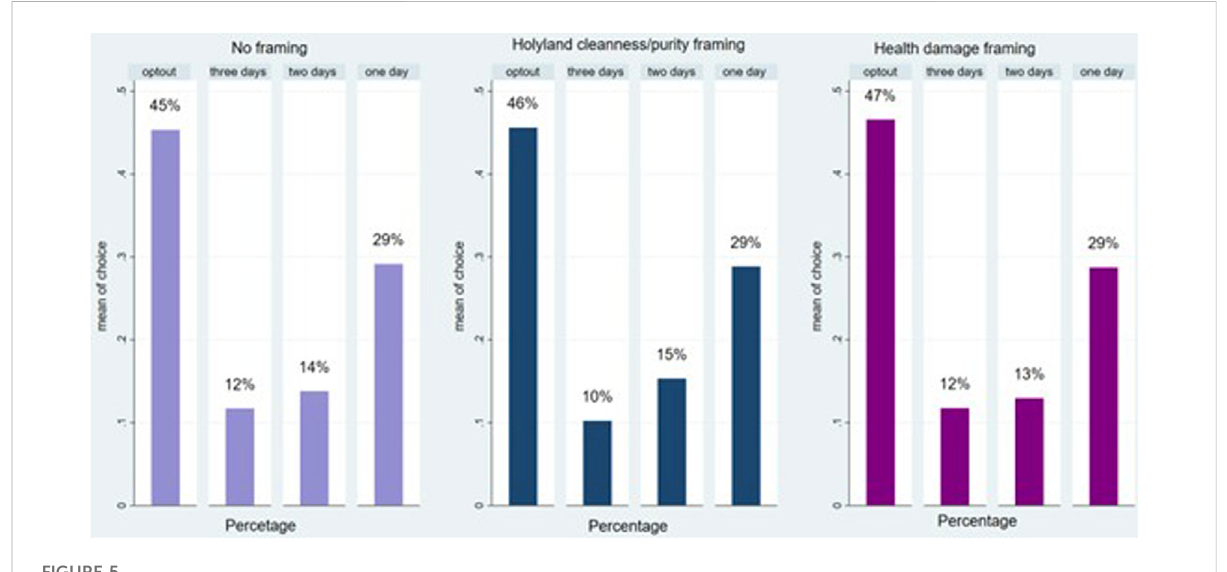
FIGURE 5 Choice distribution across the different framing